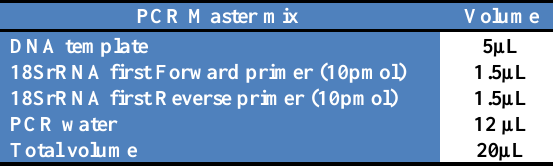
Table, 2: Company instructions of PCR master mix.